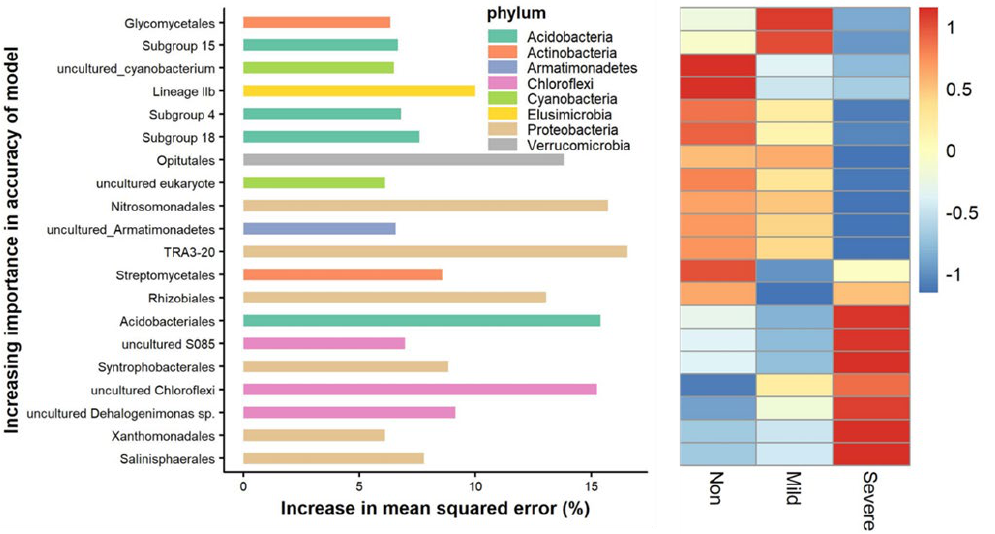
Figure 5. Random forest (RF) means predictor importance (percentage of increase in mean square error) of microbial species at order level and the corresponding relative abundances (z–score trans- formed) of the soils with three salinity levels: Non–salinity, Mild–salinity and Severe–salinity. The accuracy importance of the model was computed for each tree and averaged over the forest (1000 trees). Percentage increases in the mean squared error (MSE) of variables were used to estimate the importance of these predictors, and higher values indicate more important predictors. Heatmap showed the variations in the relative abundances of these top 20 predictive biomarker taxa among three salinity